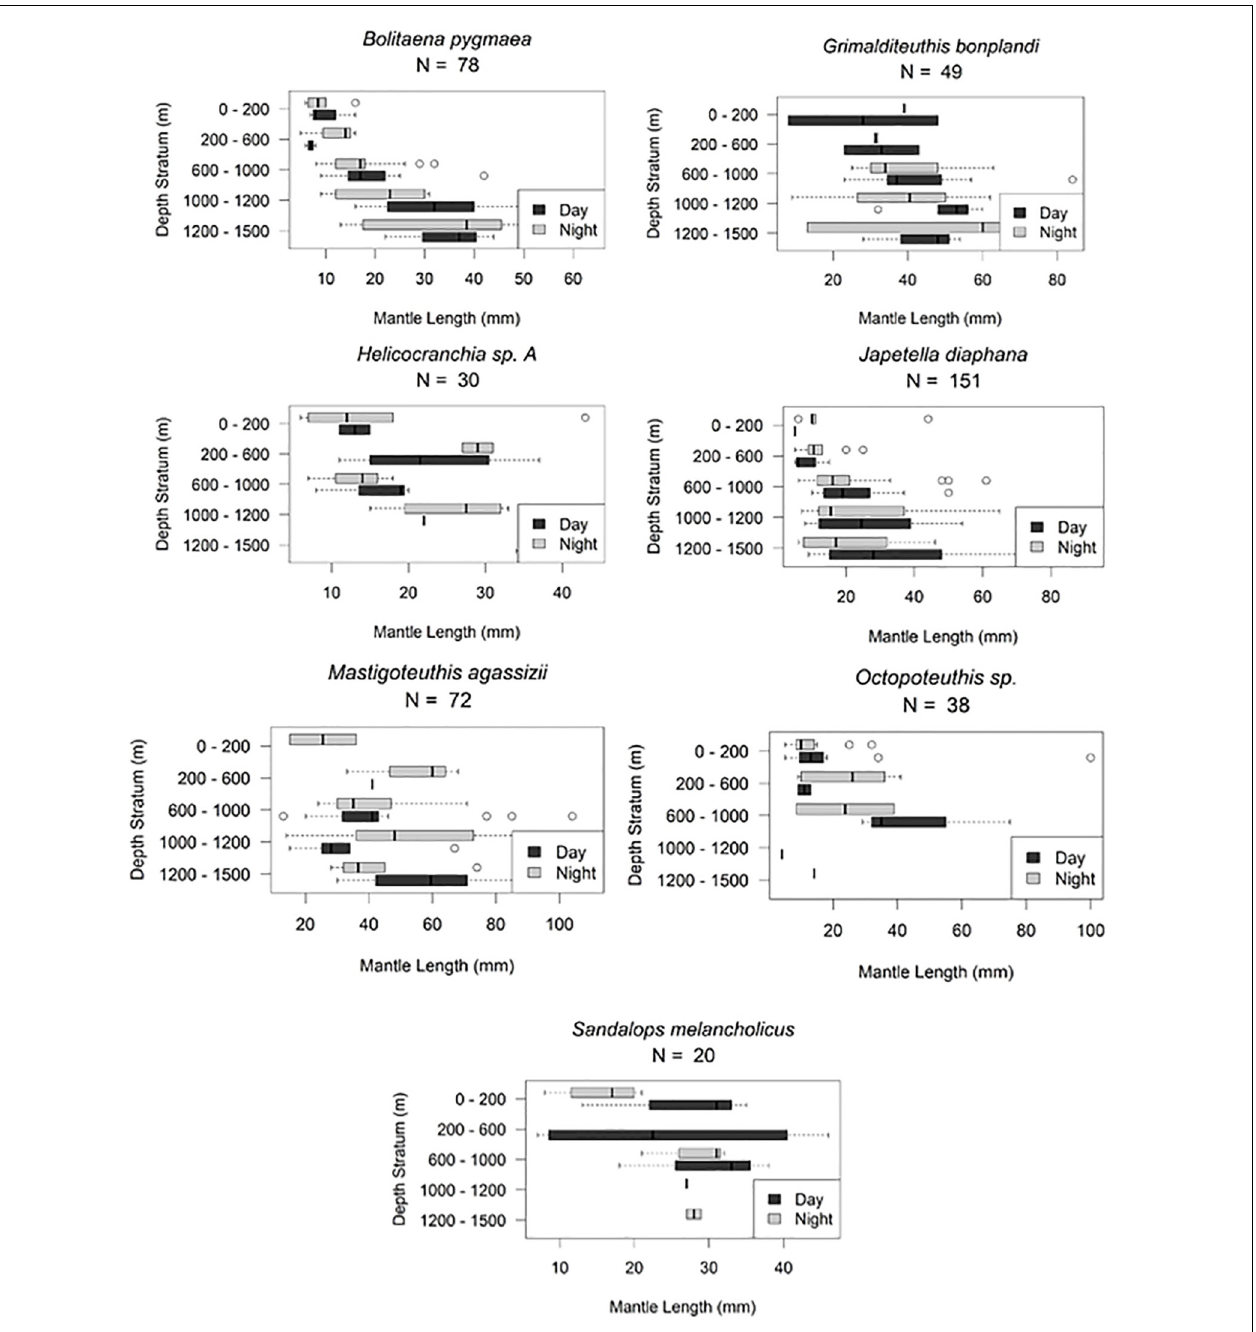
FIGURE 8 | Cephalopod ontogenic shift patterns demonstrating a shift deeper as these species develop. Horizontal line, median; box limits, 1st and 3rd quartiles; circles, outliers.